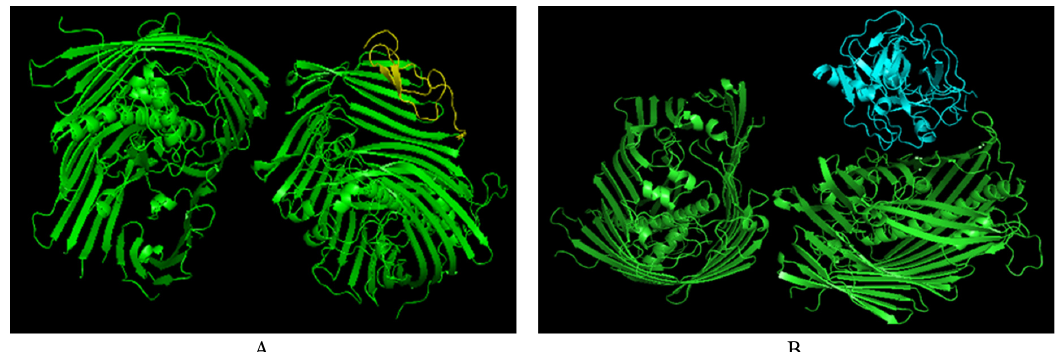
A B FigFigFigFigure 5.ure 5.ure 5.ure 5. Salmonella enterica lipopolysaccharide protein docking using PyMOL; (A) Salmonella enterica lipopolysaccharide protein with coagulation factor VII (yellow); (B) Salmonella enterica lipopolysaccharide protein with coagulation factor VII